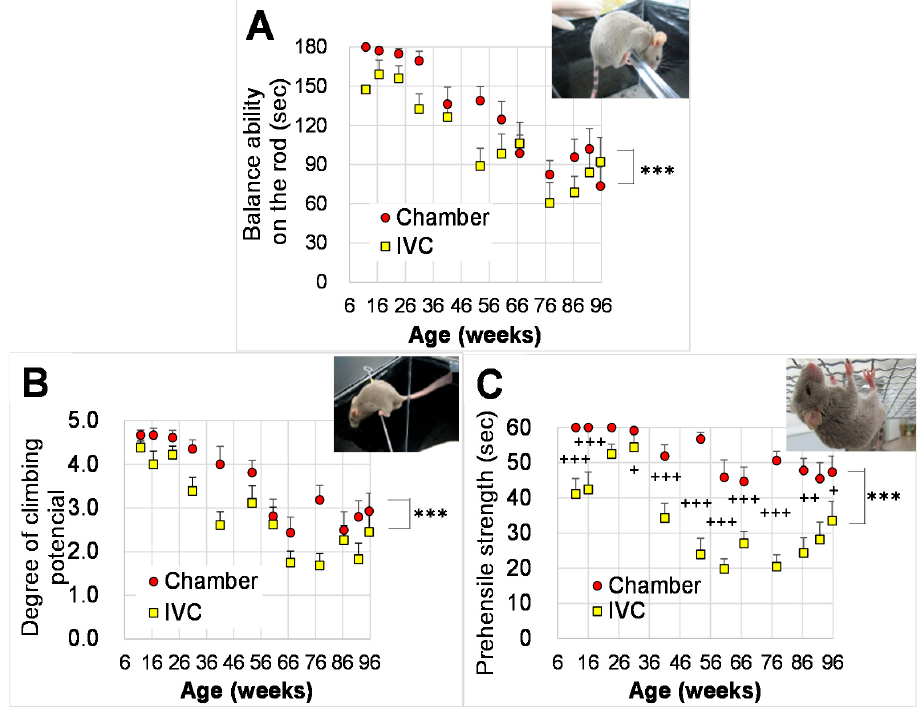
Figure 5. Changes in physical performance with aging in the chamber and IVC groups: physical performance in balancing abilities on ( A ) an acryl rod (Test 1), ( B ) horizontal bar (Test 2), ( C ) wire hanging (Test 3). *** p < 0.001 by two-way ANOVA, ††† p < 0.001; †† p < 0.01; † p < 0.05 by Bonferroni’s post-hoc test for multiple comparisons.